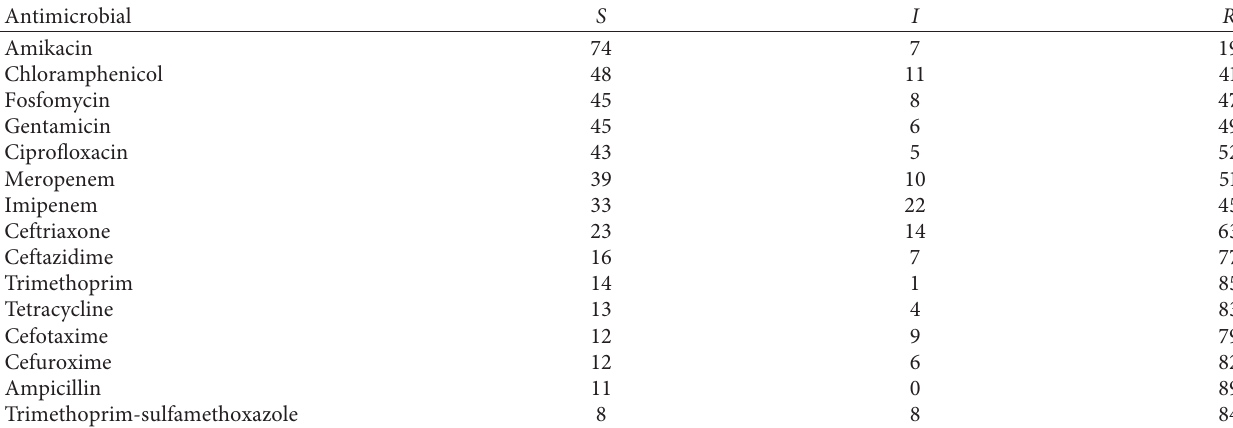
Table 3: Percentage of antimicrobial resistance of Enterobacteriaceae tested against 15 antimicrobials. Antimicrobial